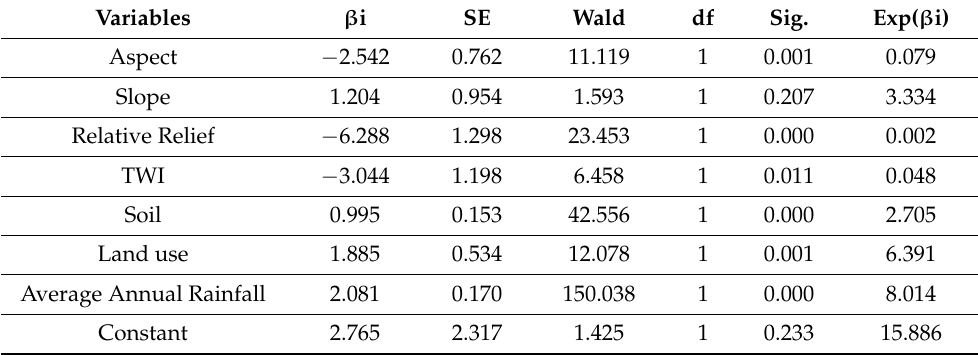
Table 3. Factors selected for modelling landslide susceptibility and their estimated